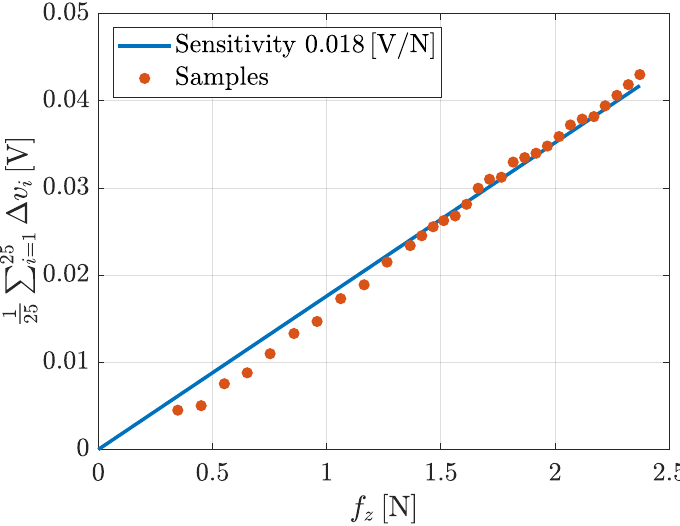
Figure 18. Sensitivity graph for the whole pad